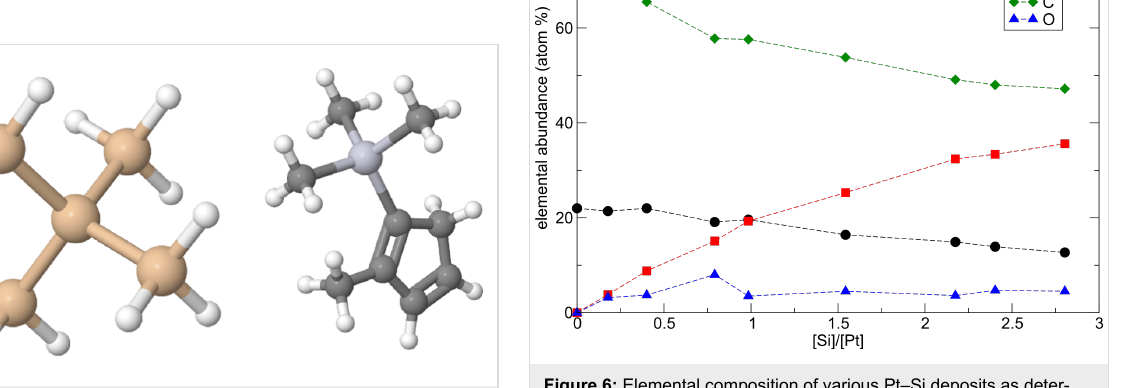
Figure 5: Molecular models of Si 5 H 12 (left) and Me 3 Pt(IV)CpMe (right). Rendered using Jmol.